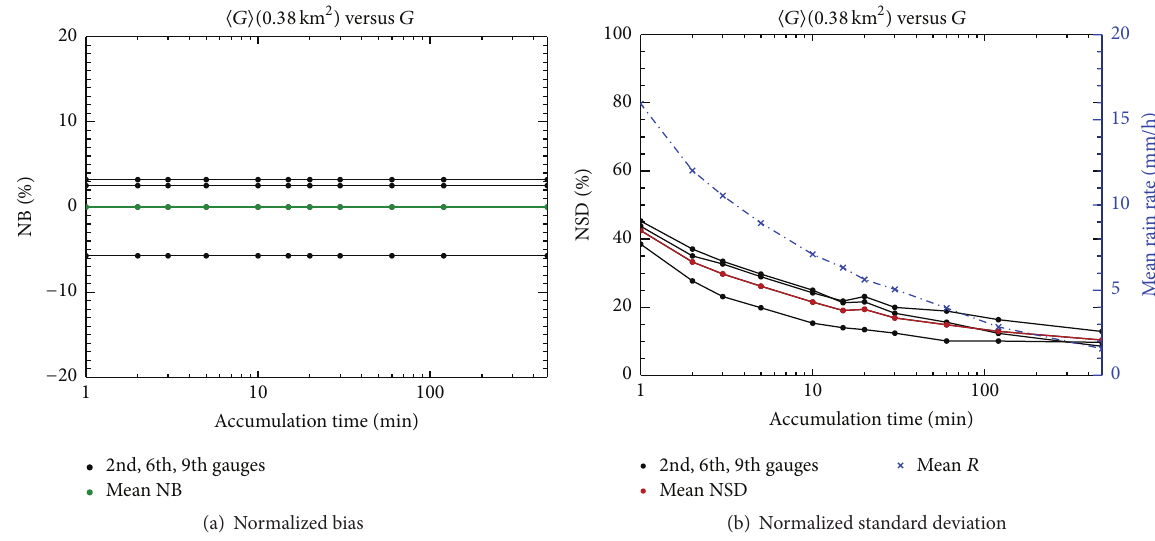
Figure 15: (a) The NB and (b) NSD between ⟨𝐺⟩(0.38 km 2 ) and 𝐺 from three rain gauges with accumulation time. ⟨𝐺⟩ is the temporally averaged rainfall rate of ⟨𝐺⟩ .